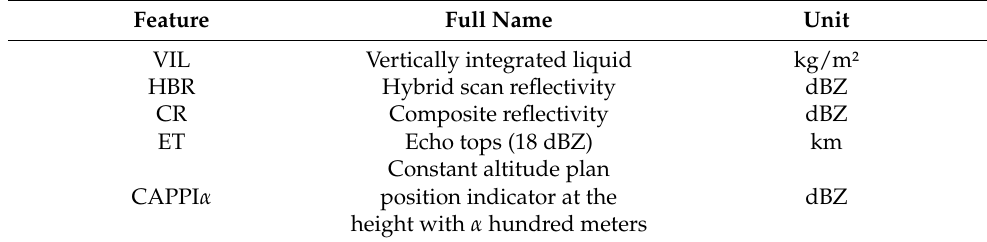
Table 1. The full names and units of the input radar